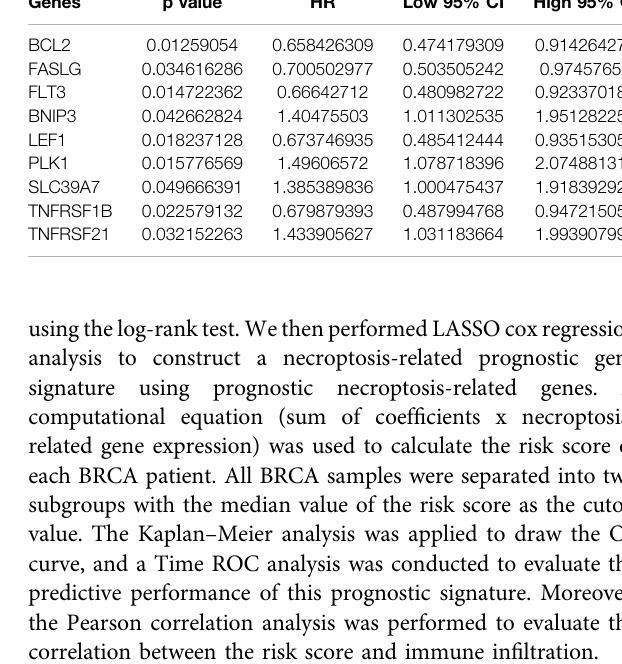
TABLE 1 | Necroptosis genes with prognostic signi fi cance in overall survival analysis. Genes